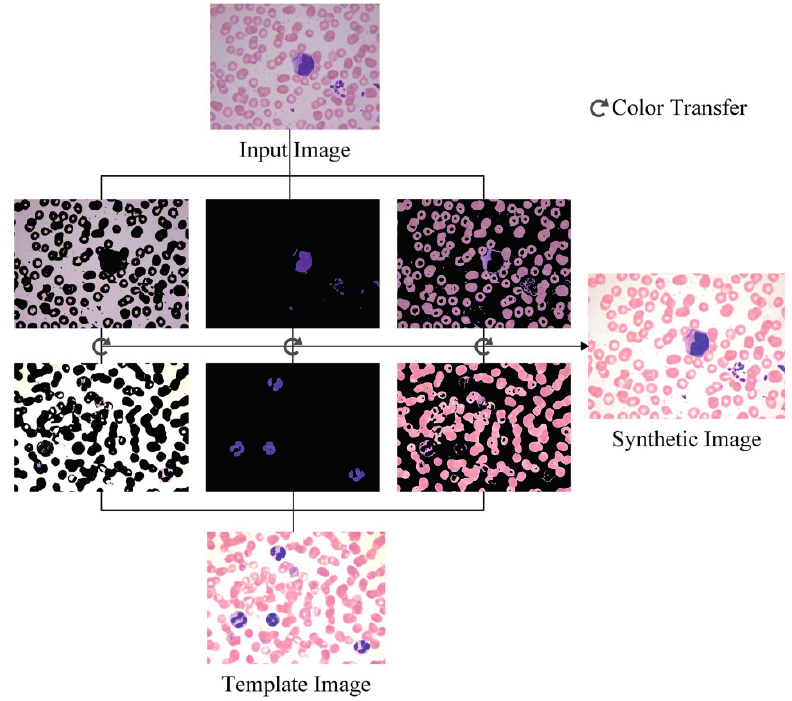
Figure 5. Schematic plot of the proposed color adjustment